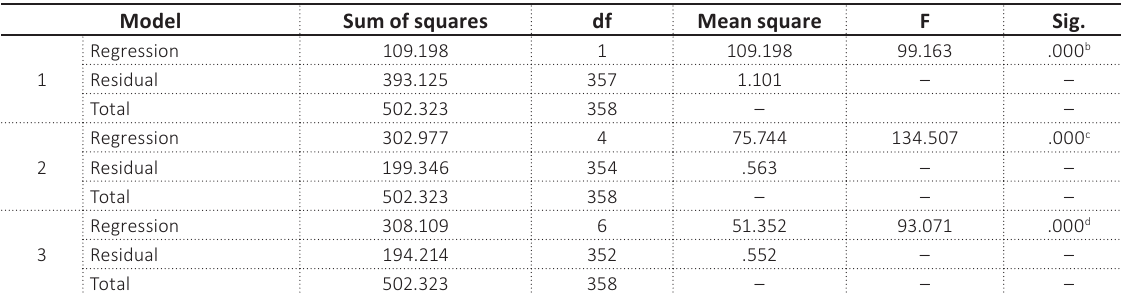
Table 4. Model F-test a